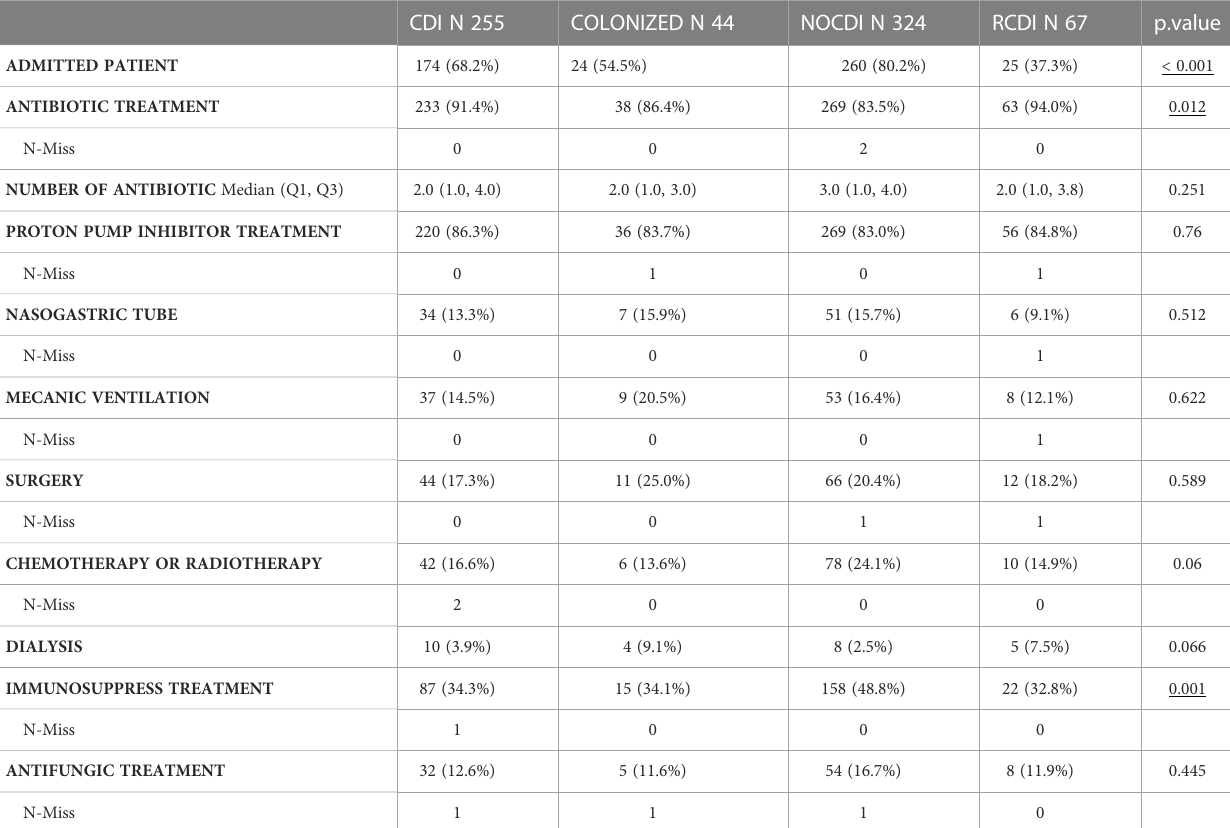
taken probiotics (Supplementary Table 2). No signi fi cant differences in alpha diversity were seen in CDI, colonized patients, or R-CDI related to the presence or absence of toxin detected by Quick Check. TABLE 2 CDI development risk